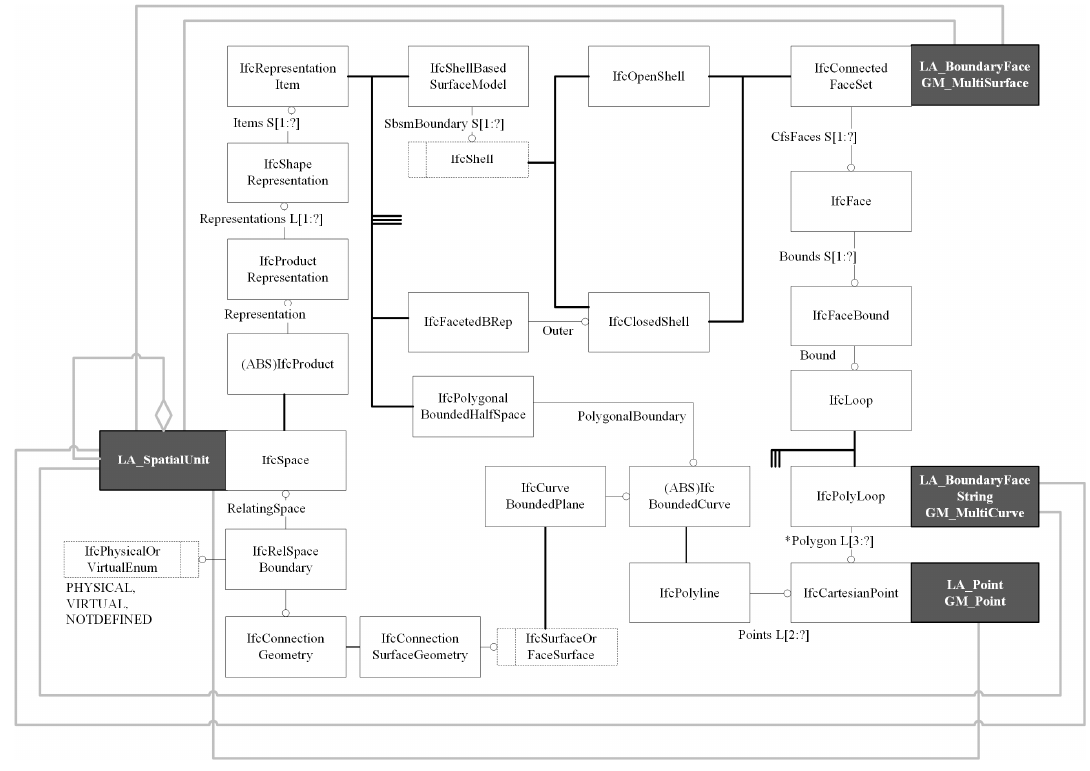
Figure 5. Mapping between the LADM and the IFC: Geometry.